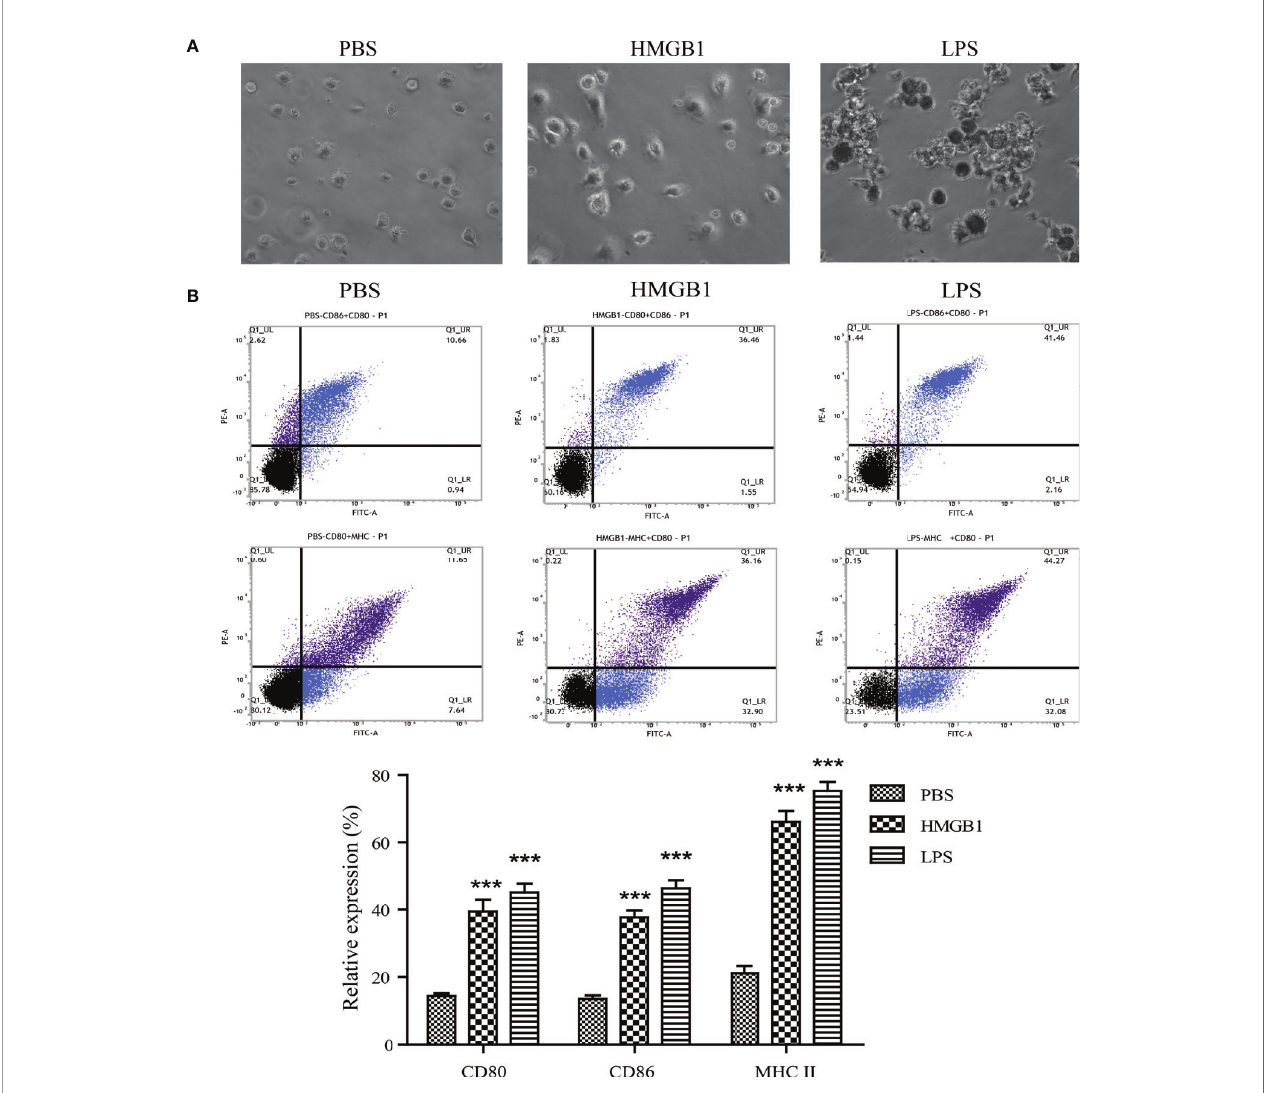
FIGURE 4 | Features and expression of surface markers on DCs stimulated with HMGB1. DCs were stimulated with PBS, HMGB1, or LPS and the surface expressions of CD80, CD86, and MHC II were detected by fl ow cytometry. (A) Features of DCs stimulated with PBS, HMGB1, or LPS (magni fi cation, ×400). Cultured DCs had irregular protrusions on their surfaces, especially the HMGB1- or LPS-pulsed DCs. (B) The percentage of surface marker expression on DCs stimulated with various antigens. HMGB1- or LPS-pulsed DCs had a higher expression of CD80, CD86, and MHC II compared with the PBS control. The lower panel shows the means ± standard deviations of the results from three individual experiments. *** p < 0.001 compared with the PBS